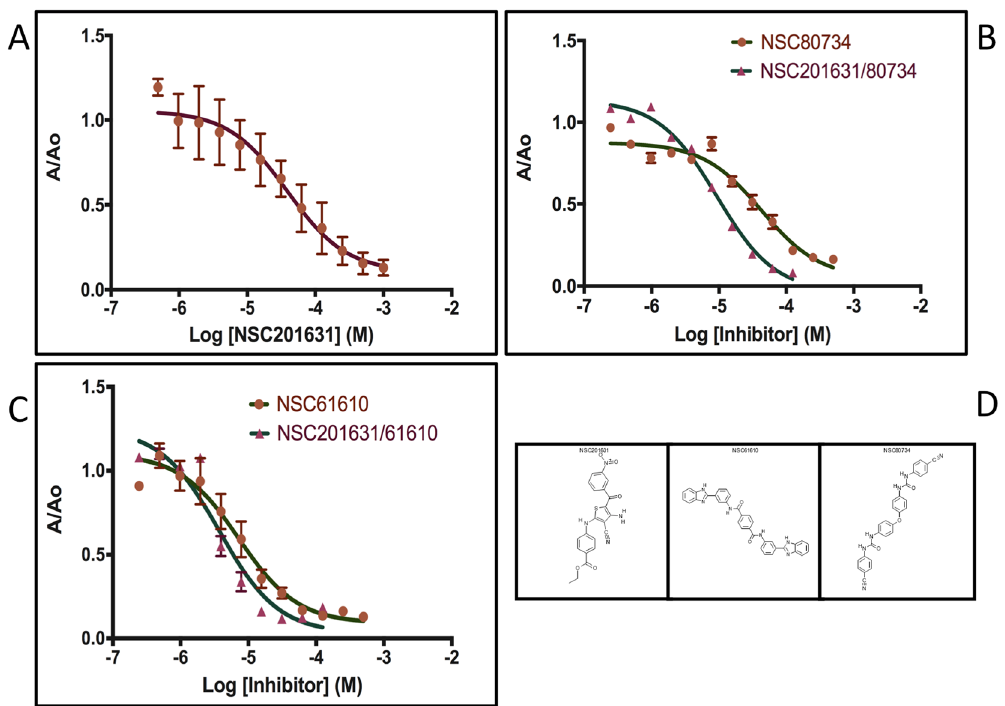
Figure 2. Competitive ELISA and IC 50 determination. Dose-response curves with varying compound concentrations for the inhibition of hIL-18:ectvIL-18BP complex formation. IC 50 values were obtained by nonlinear regression fitting to a variable slope, three-parameter dose-response model using the GraphPad Prism 6 software (San Diego, CA, USA). Competitive ELISA experiments were performed using four technical replicates. ( A ) Competitive ELISA curve for NSC201631, IC 50 = 44 + / − 9 uM, n = 3. ( B ) Competitive and Synergistic ELISA results for NSC80734, IC 50 = 52 + / 38 uM, n = 3 and NSC201631/80734 (IC 50 = 9.3 uM). ( C ) Competitive and Synergistic ELISA results for NSC61610, IC 50 = 6 + / − 5 uM, n = 2, and NSC201631/61610 (IC 50 = 3.7 uM) ( D ) Two-Dimensional Chemical Structure of NSC201631, NSC61610, an NSC80734. Note: Synergistic competitive ELISA results obtained from four technical replicates of a single assay (n = 1). Standard deviation from mean is plotted with error